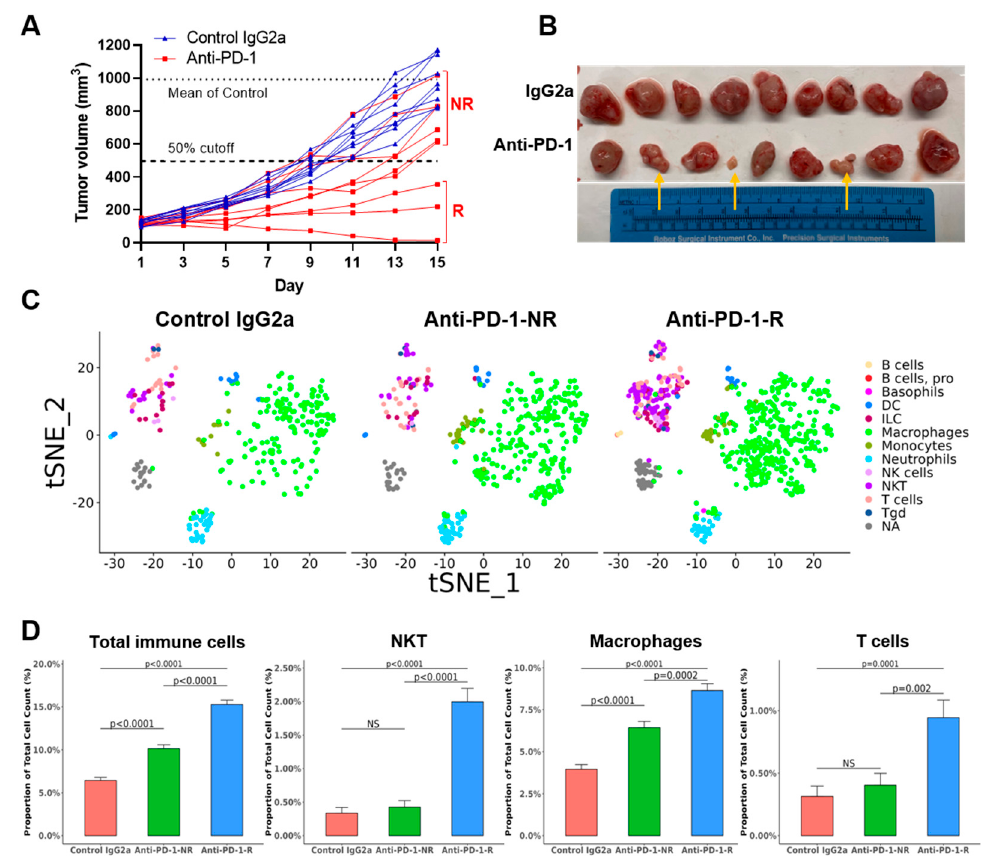
Figure 4. The treatment responses of the TKO tumors to anti-PD-1 in C57 BL/6J mice. ( A ) Individual tumor volume growth curves in C57 mice ( n = 18) bearing TKO tumors treated with anti-PD-1 ( n = 9, red) or control IgG2a ( n = 9, blue). The mean volumes of non-responders (NR) and responders (R) were 765.1 mm 3 and 196.4 mm 3, respectively ( p = 0.01, Welch’s t test). ( B ) The gross tumors of the anti-PD-1 group (lower) and the control group (upper). Anti-PD-1 immunotherapy resulted in